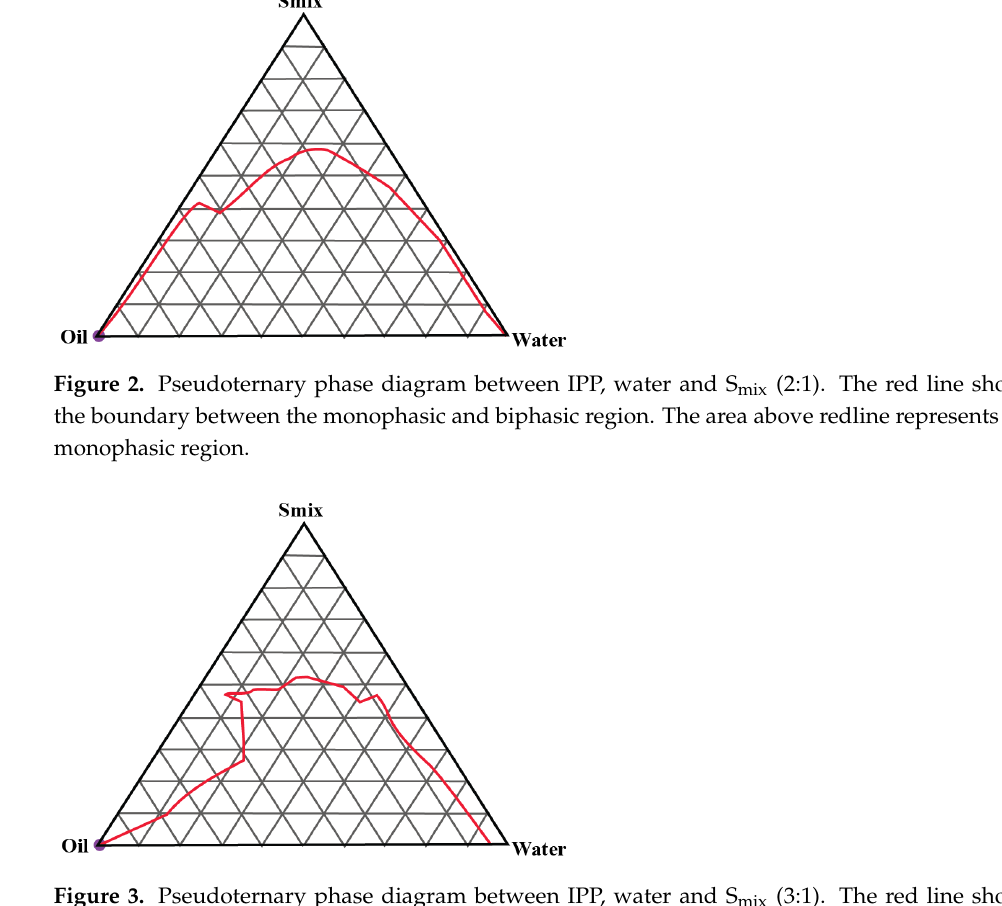
Figure 3. Pseudoternary phase diagram between IPP, water and S mix (3:1). The red line shows the boundary between the monophasic and biphasic region. The area above redline represents the monophasic region. Table 1. The characterisation of various developed microemulsion